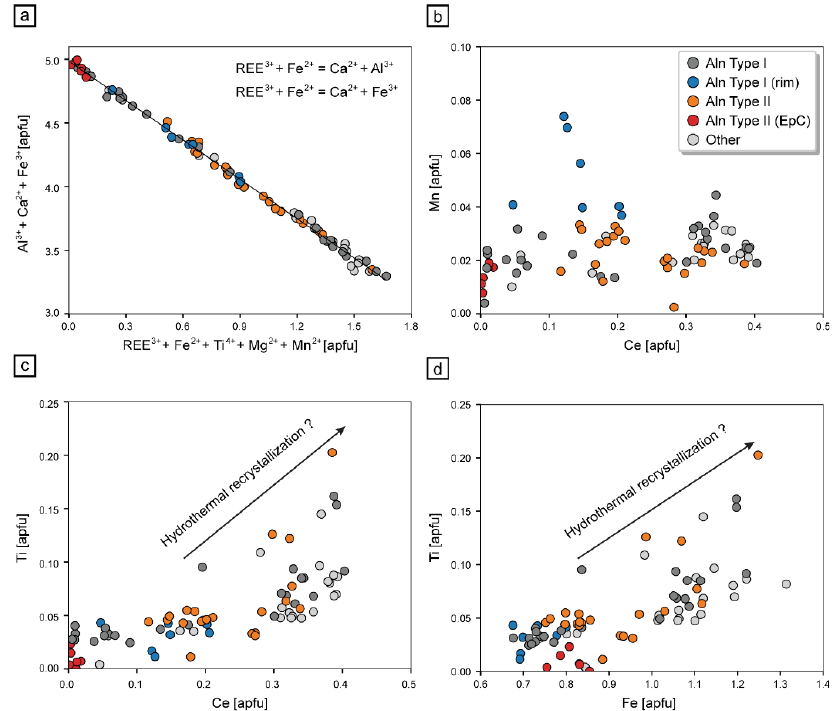
Figure 8. Cationic plots of defined allanite types relating the groups of elements resulting from the principal component analyses. ( a ) REE 3+ + Fe 2+ + Ti 4+ + Mg 2+ + Mn 2+ vs. Al 3+ + Ca 2+ + Fe 3+ showing the cationic substitutions in allanite structure. ( b ) Ce vs. Mn. ( c ) Ce vs. Ti. ( d ) Fe vs. Ti. [apfu] = atoms per formula unit. See explanation in the text.